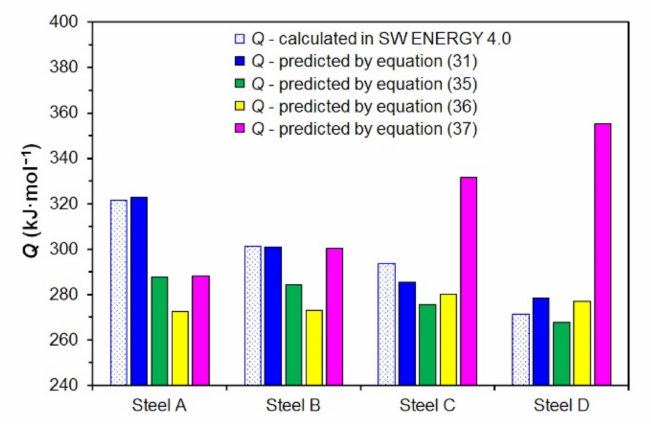
Figure 19. Comparison of values of the hot deformation activation energy Q of investigated steels determined by the ENERGY 4.0 software and using Equations (31) and